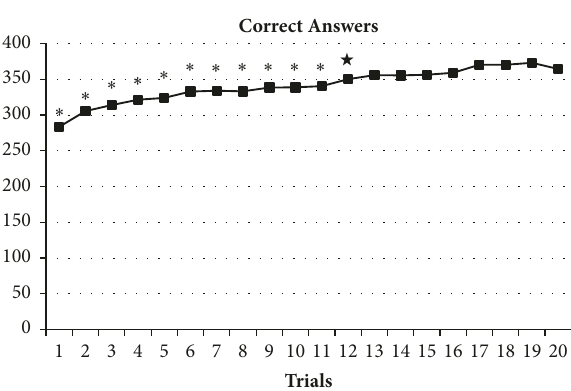
Figure 4: Mean number of correct answers in the calculation task up to the trial 20. ∗ P < 0.05 versus the trial 20, ‰ P < 0.05 versus the mean of trials 16 –